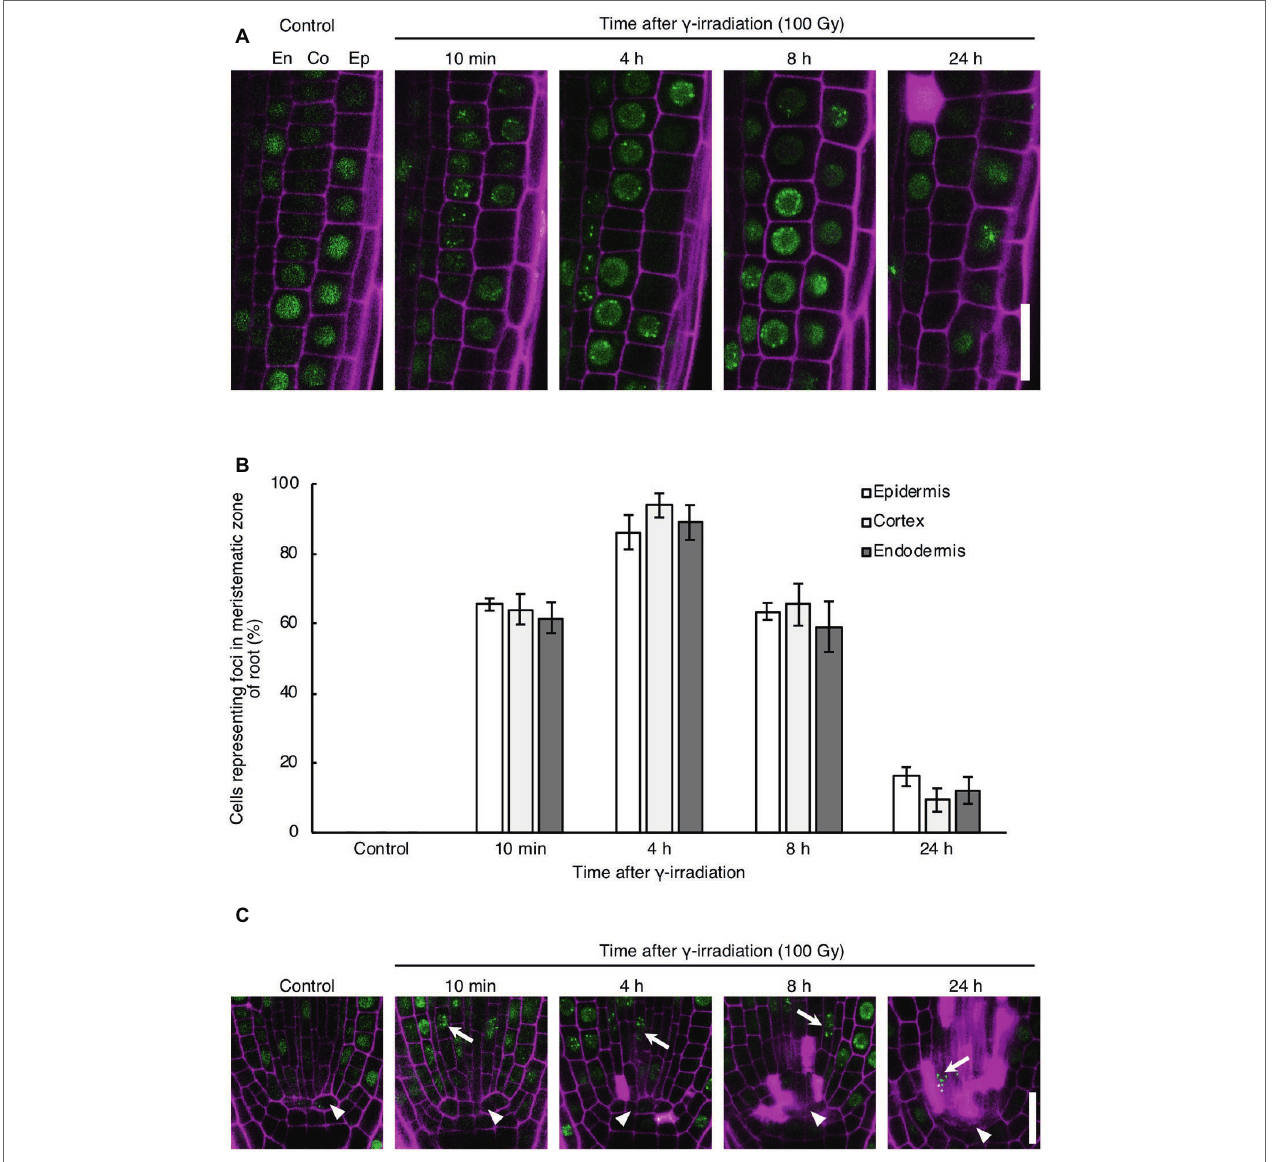
FIGURE 1 | Dynamics of the formation of RAD54 foci in Arabidopsis root cells with DNA double-strand breaks. (A) Epidermal, cortical, and endodermal cells in the root meristematic zone of plants expressing RAD54-EYFP after γ -irradiation (100 Gy). Green: RAD54-EYFP. Magenta: propidium iodide. Scale bar: 20 μm. (B) Detection frequency of cells showing RAD54 foci in the epidermis, cortex, and endodermis in the root meristematic zone at 10 min, 4 h, 8 h, and 24 h after γ -irradiation (100 Gy). Error bars indicate the standard error. At least five roots were counted for each group. (C) Stem cells and quiescent center (QC) cells in the root meristematic zone of plants expressing RAD54-EYFP after γ -irradiation (100 Gy). White arrows and arrowheads indicate stem cells and QC cells, respectively. Green: RAD54-EYFP. Magenta: cell wall. Scale bar: 20